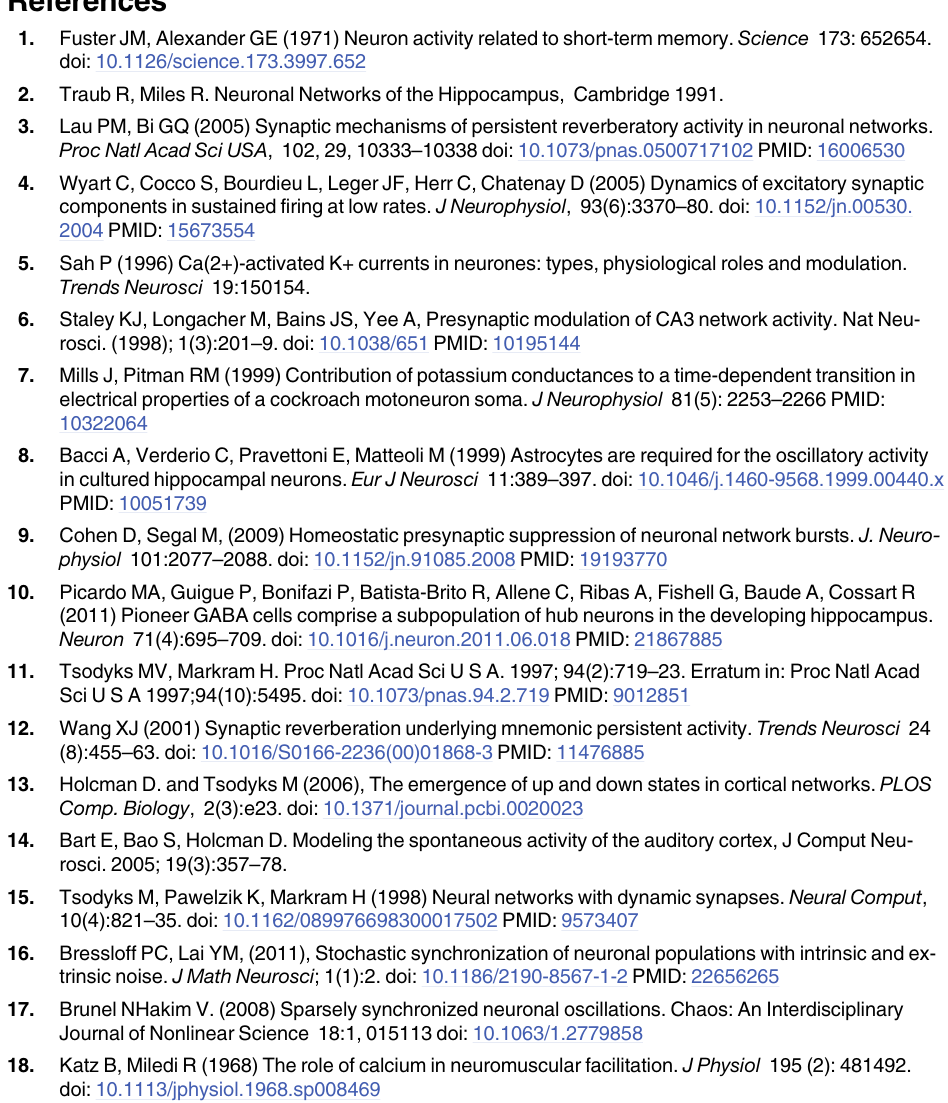
(cid:129) Figure E. Comparison between the depression variable y estimated by equation 8 (blue) and the exact one obtained by numerical simulation of system 2 (black). (cid:129) Figure F. Comparison between numerical simulations and estimates of the reverberation time T R . The reverberation time is plotted as a function of J for the exact model (solid line), the approximated model (dash black line), and the estimates given by equations 37 (dash red line) and 39 (blue dash